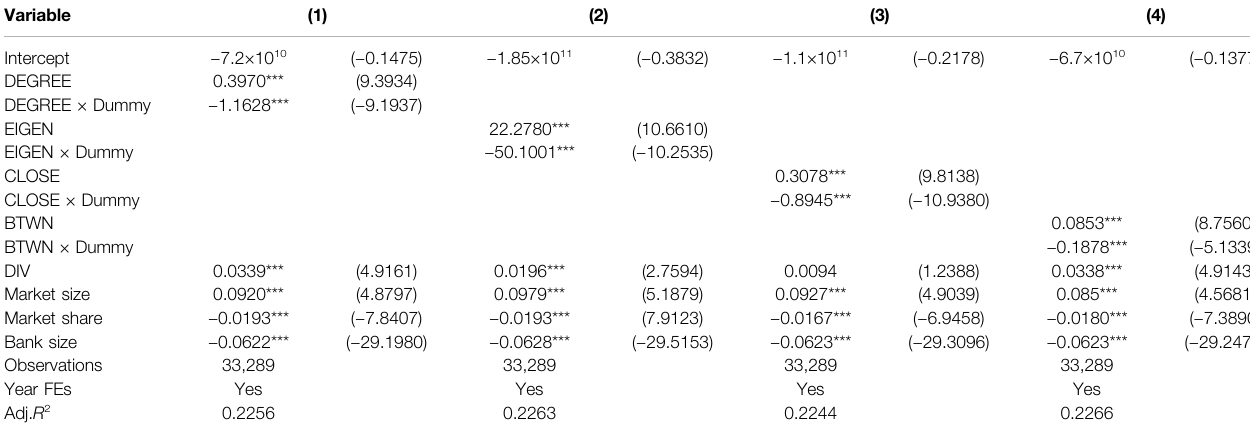
Thistablereportstheregressionsoffourdimensionofconnectednessanddiversi fi cationonROA:degreecentrality(DEGREE),eigenvectorcentrality(EIGEN),closenesscentrality(CLOSE), andbetweennesscentrality(BTWN).ROAisde fi nedasthenetincomedividedbytotalassets.Consistentwith Section2.2 ,thecentralityindicesofthebanksaremeasuredforeachmonth.